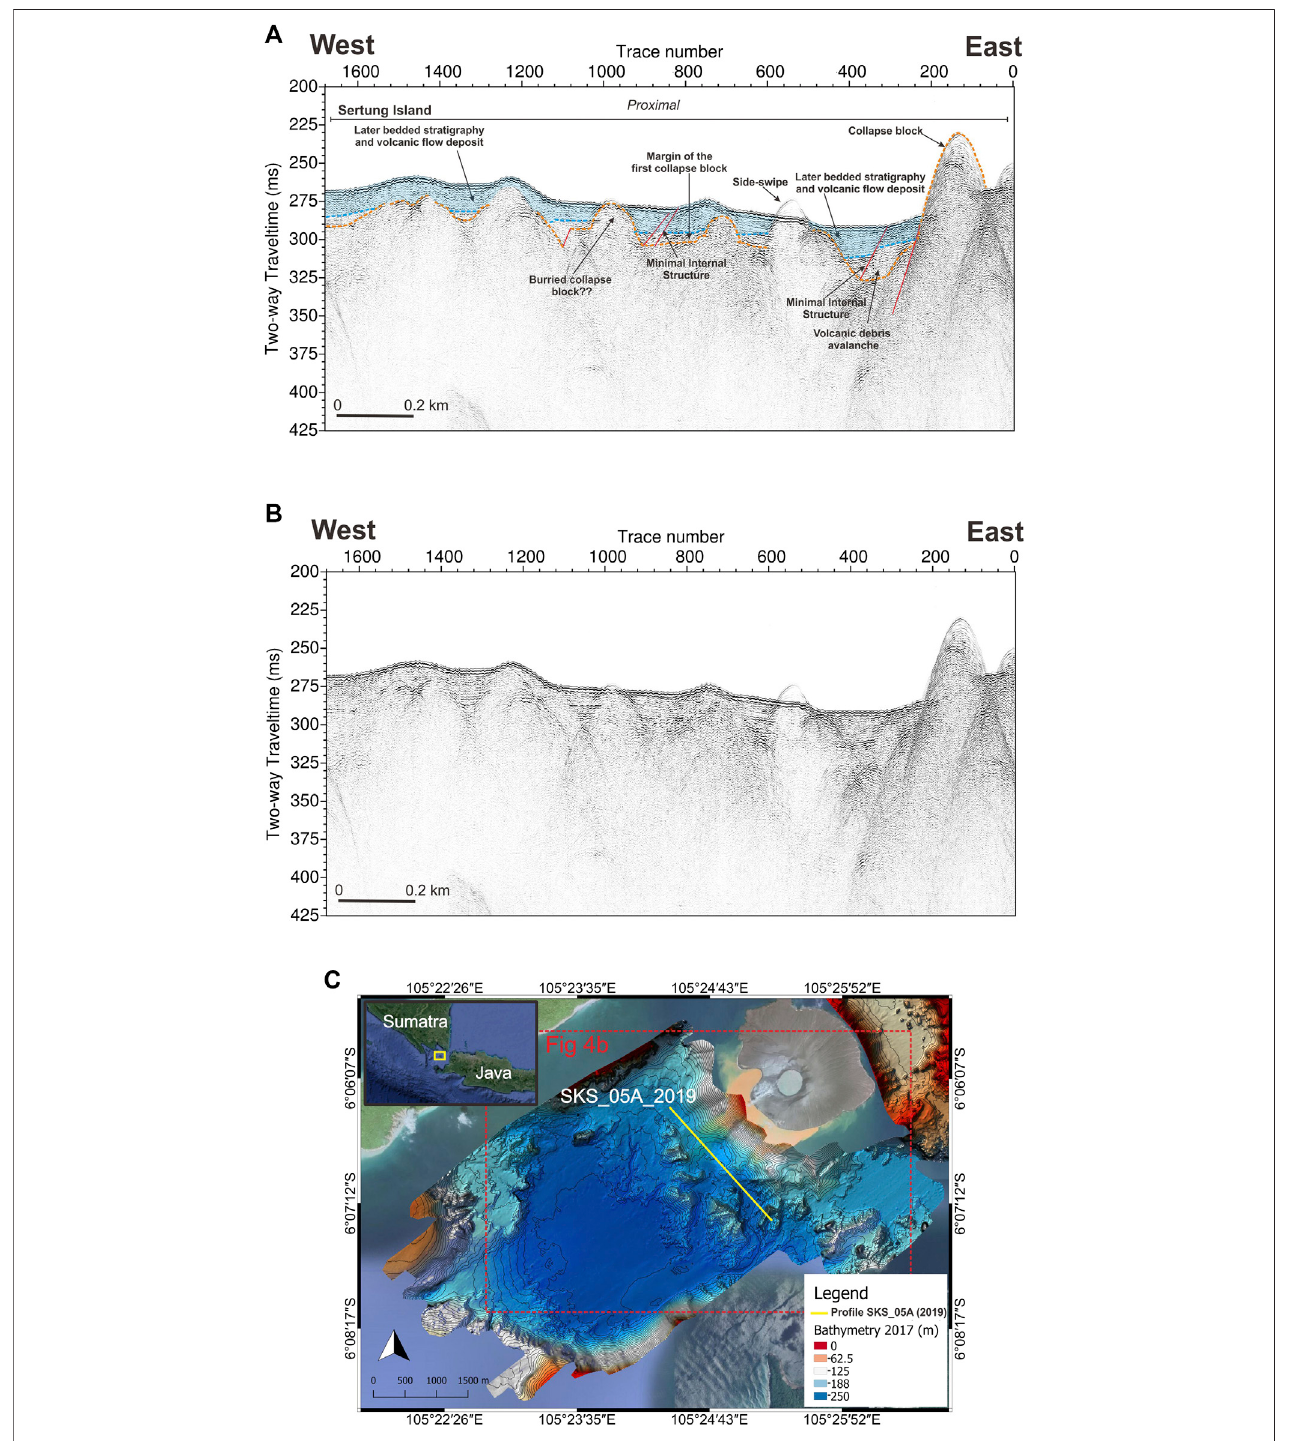
FIGURE 7 | Seismic Pro fi le SKS-05A (2019 Data) with 2:1 exaggeration (The light-brown striped line is consider as basal collapse block). (A) Interpreted of the Seismic Pro fi le SKC-03. (B) Uninterpreted of Seismic Pro fi le SKC-03. (C) The Seismic Pro fi le SKC-03 location.